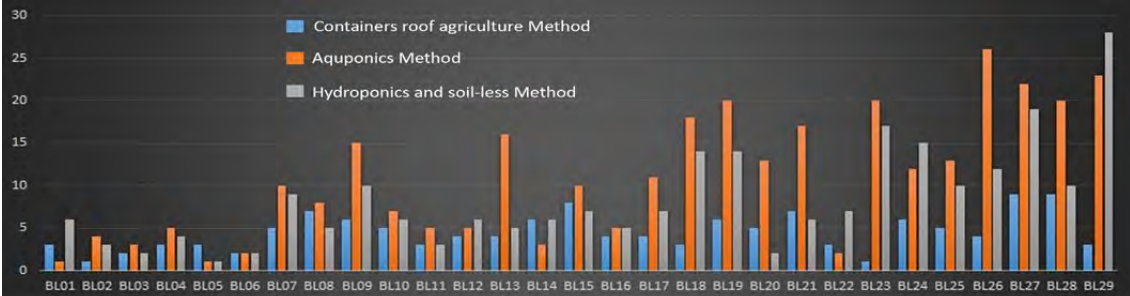
Figure 21. Comparison between the number of families who chose different each type of Roof